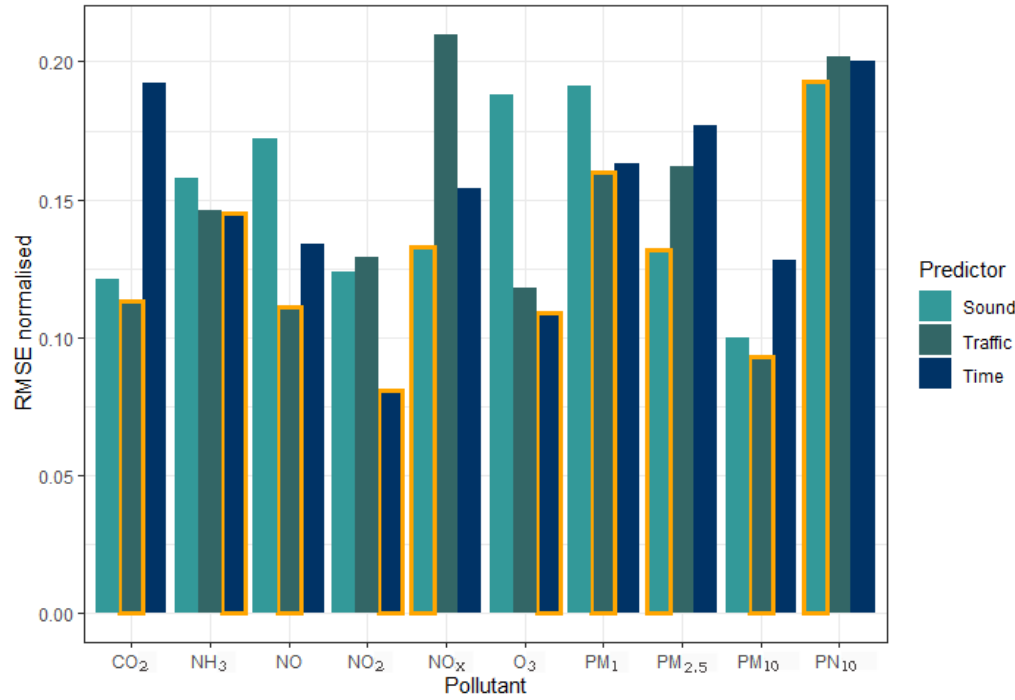
Figure 7. Normalised RMSE values for the prediction of pollutant concentrations (CO 2 , NH 3 , NO, NO 2 , NO x , O 3 , PM 1 , PM 2.5 , PM 10 , and PN 10 ) with sound, traffic, and time data. Orange framed bars indicate the smallest error for each pollutant.